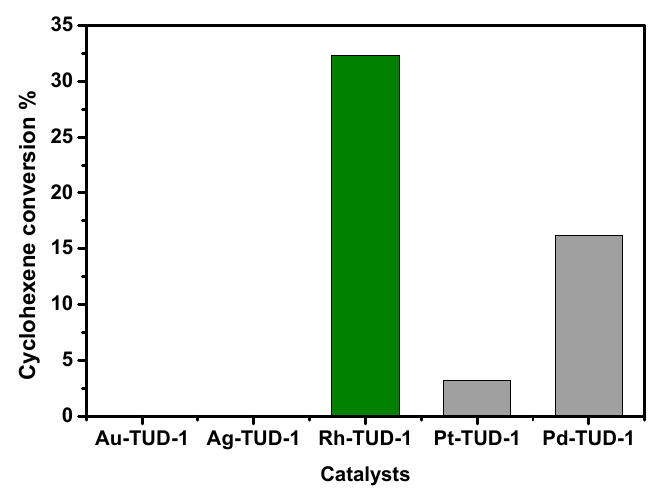
Figure 11. Comparison between the activity of different noble metals incorporating TUD-1 in the hydrogenation of cyclohexene under solvent-less and ambient conditions.